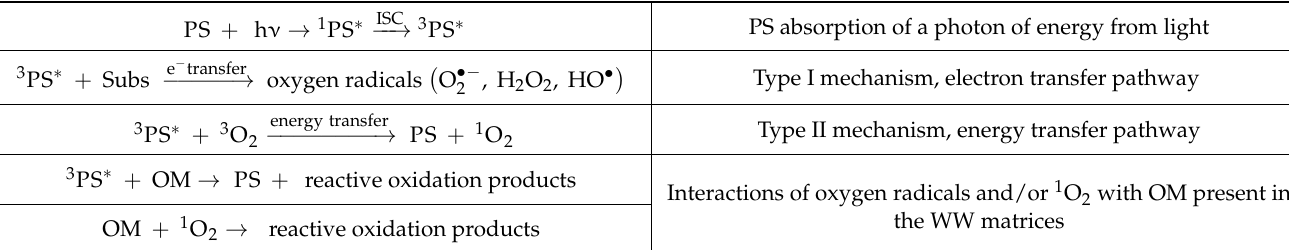
Table 1. Schematic representation of possible positive effects that the presence of organic matter (OM) in the aPDT matrix (WW) may have on the antimicrobial inactivation